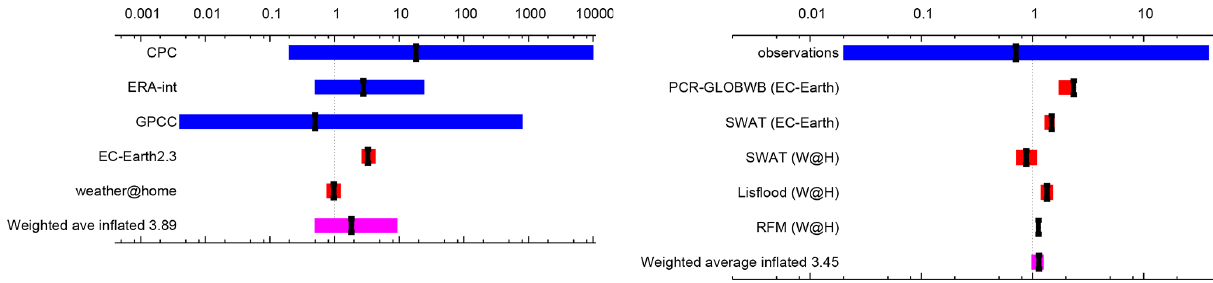
Figure 2. Synthesis of the probability ratios between pre-industrial and 2017 of the precipitation (left) and discharge (right) results. Dark blue is observations, red is climate model ensembles, and the weighted average is shown in purple. The ranges of the models are not compatible with each other, pointing to model uncertainty playing a role over the natural variability. The weighted average has been inflated by factors of 3.89 and 3.45 for precipitation and discharge respectively to account for the model spread. Reproduced from Philip et al. (2019) under the licence agreement at https://creativecommons.org/licenses/by/4.0/ (last access: 31 October 2018); see original paper for more